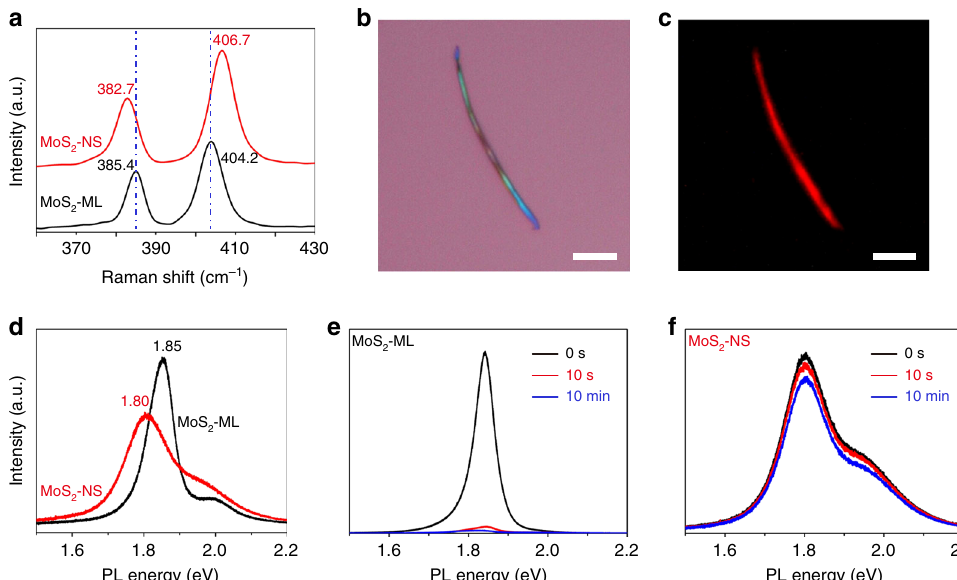
Fig. 3 Optical characterization of MoS 2 -NSs (nanoscrolls). a Raman spectra of chemical vapor deposition (CVD)-grown MoS 2 monolayers (MoS 2 -ML, black line) and MoS 2 -NSs (red line) with 532 nm excitation. b Optical image of a typical MoS 2 -NS. c Corresponding fl uorescence image of the MoS 2 -NS in b . The fl uorescence image was obtained with an excitation wavelength of 510 – 560 nm. d PL spectra from MoS 2 monolayer (black line) and MoS 2 – NSs (red line) (532 nm excitation). e , f PL spectra response of MoS 2 monolayer ( e ) and MoS 2 -NSs ( f ) with NH 3 doping for 0 s (black line), 10 s (red line), and 10 min (blue line) (scale bars, 5 μ m in b and c